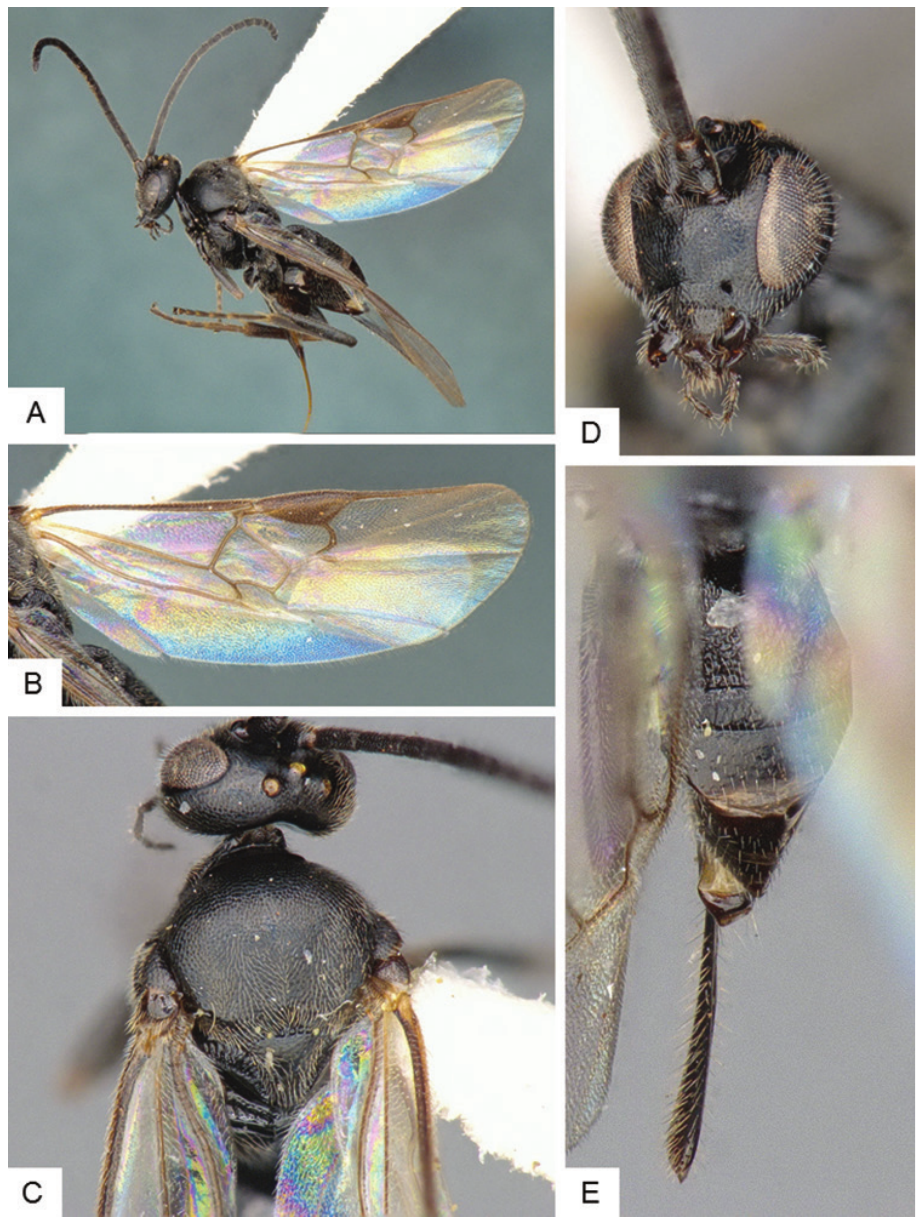
Figure 8. Dolichogenidea sicaria . A Habitus, lateral B Fore wing C Head and mesosoma (partially), dorsal D Head, frontal E Metasoma (partially) and ovipositor,